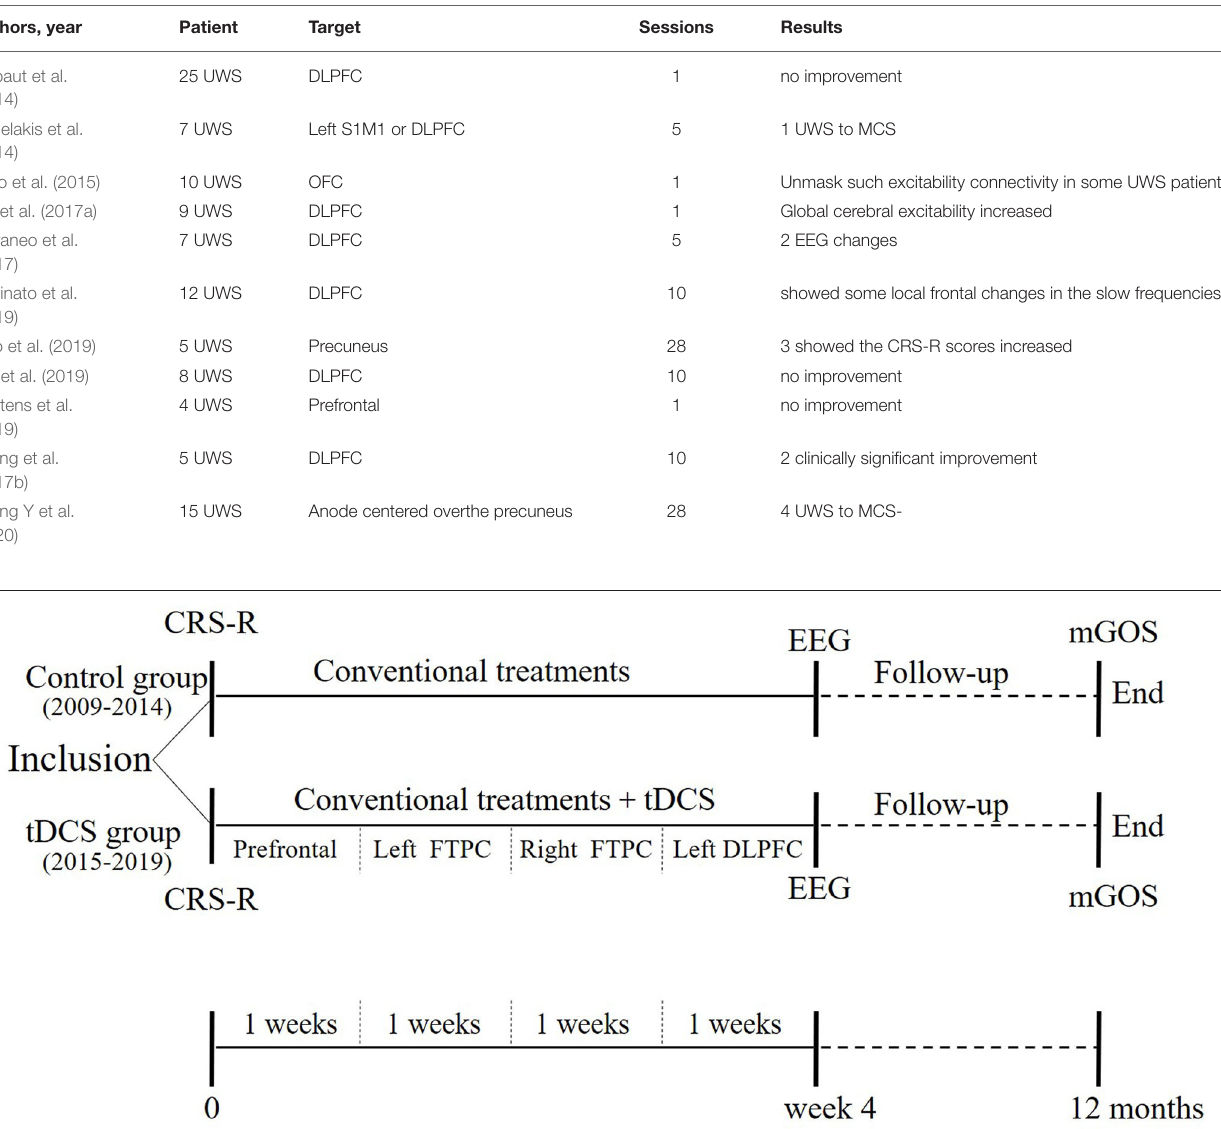
TABLE 1 | Overview of the studies on tDCS for UWS.